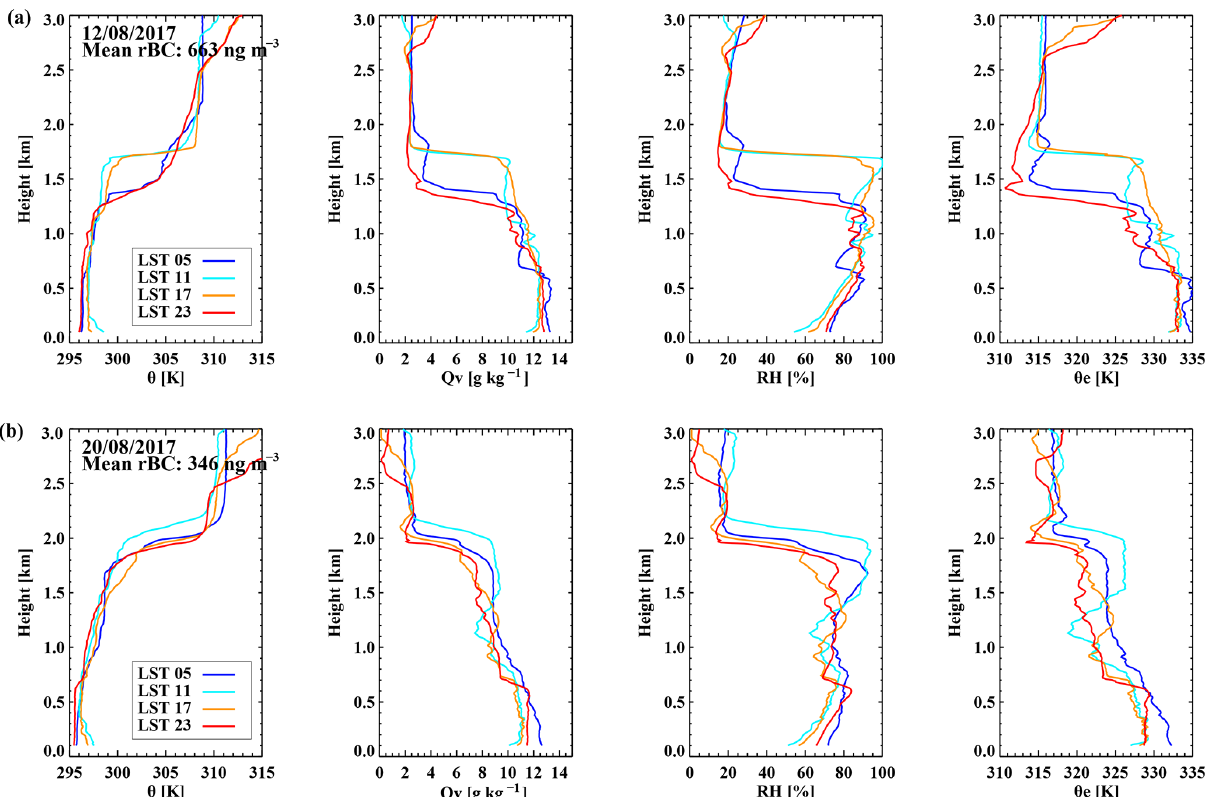
Figure 12. Individual radiosonde-derived profiles of (left to right) potential temperature, water vapor mixing ratio, relative humidity, and equivalent potential temperature for (a) 12 August 2017 and (b) 20 August 2017. Daily-mean black carbon mass concentration indicated on the left panel and radiosonde launch times within the